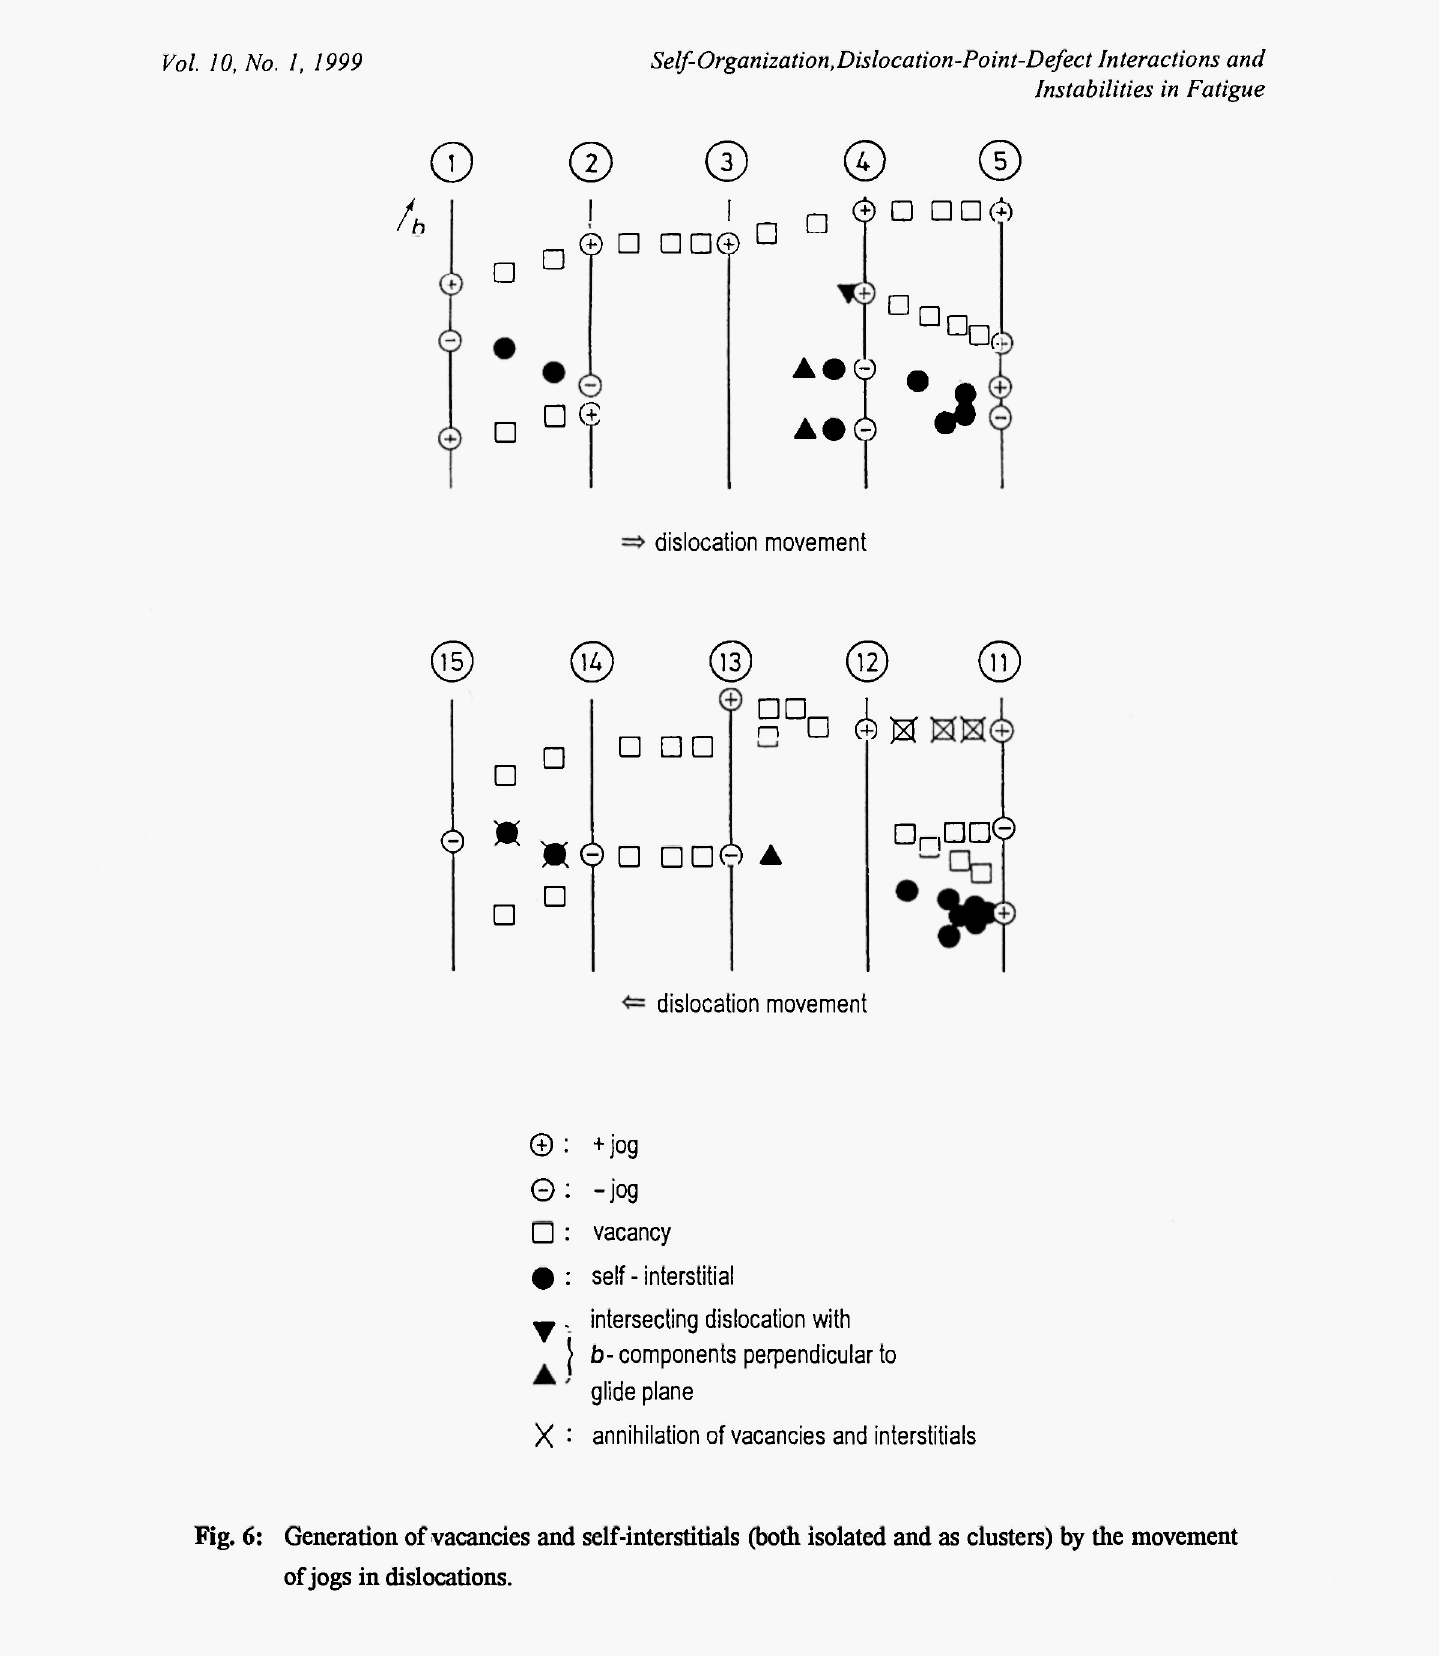
Fig. 6: Generation of vacancies and self-interstitials (both isolated and as clusters) by the movement of jogs in